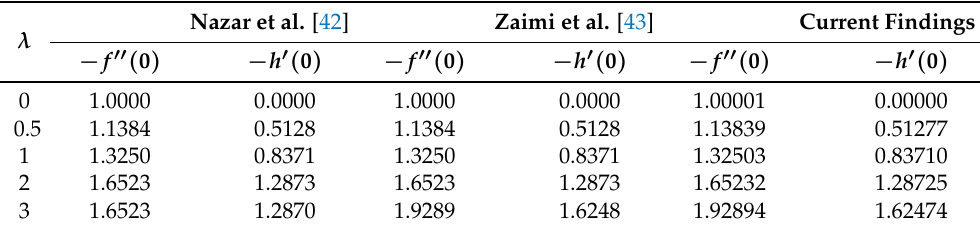
Table 1. Computing f (cid:48)(cid:48) ( 0 ) and h (cid:48) ( 0 ) values with distinct values of parameters λ and β = Fr = 0. λ